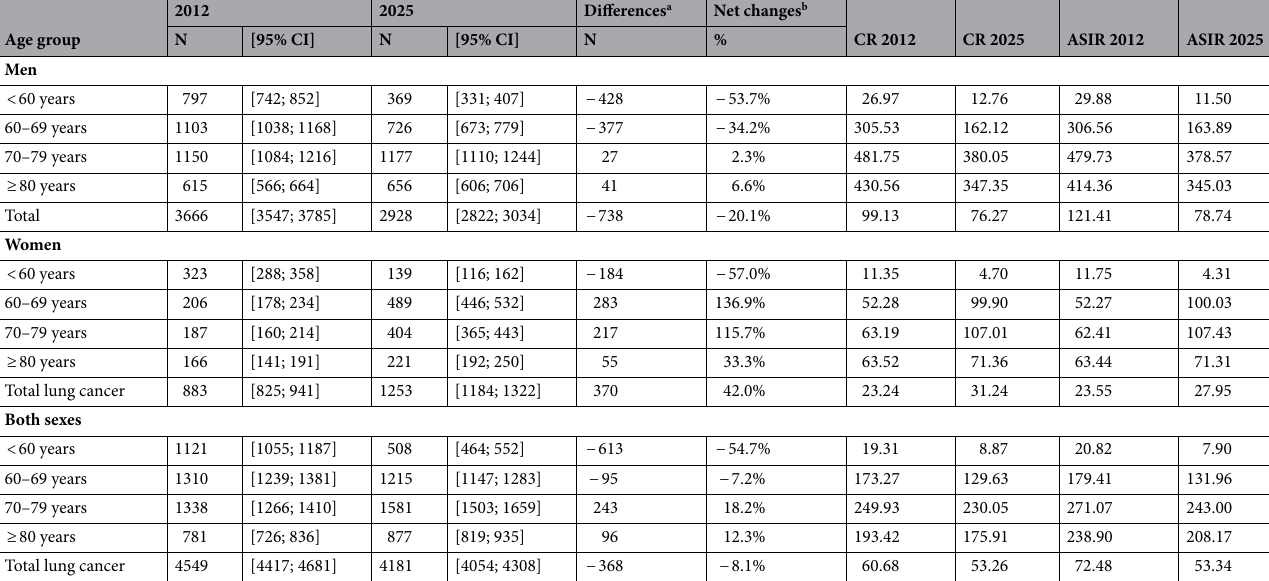
Table 1. Differences in the number of incident lung cancer in Catalonia between 2012 and 2025 by age group. CI confidence interval, CR crude rate per 100,000 person-years, ASIR age-standardised incidence rate (European Standard Population) per 100,000 person-years. a In the number of incident cases between 2025 and 2012. b In incident cases between 2012 and 2025. The age group (< 60 years) includes 0 to 60 years.